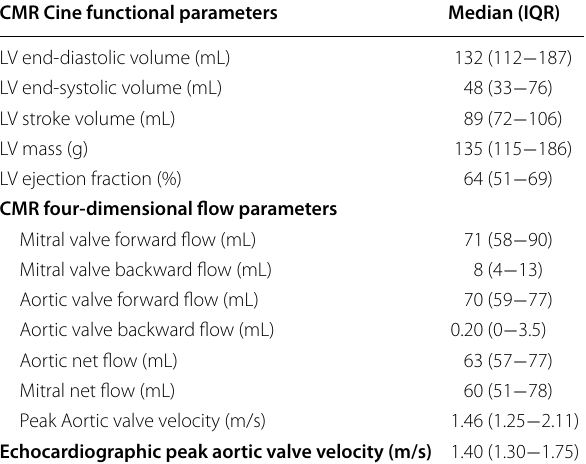
Table 3 Cardiovascular magnetic resonance (CMR) functional/ flow quantification and echocardiographic peak aortic valve